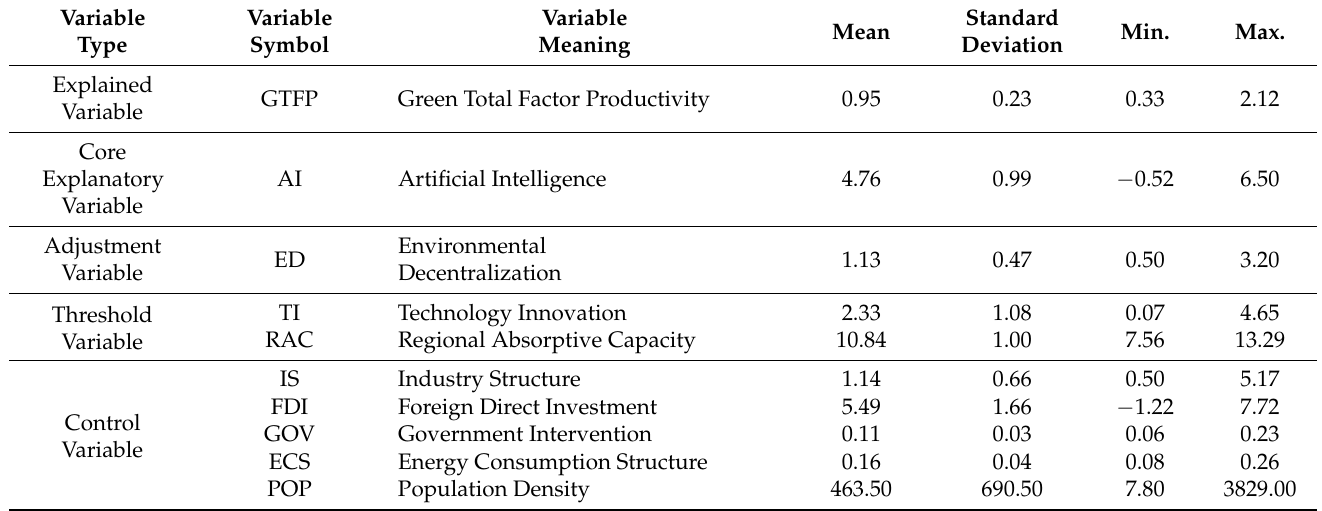
Table 2. Descriptive